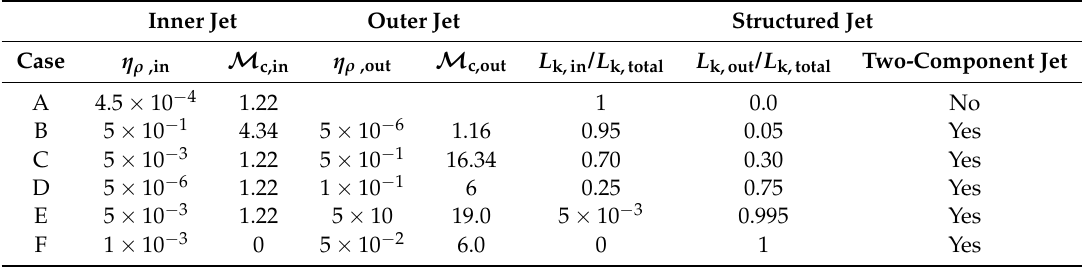
Table 1. Most relevant parameters for the two models investigated, the density ratio η ρ , the Mach number M c , the contribution of each jet components to the total kinetic energy flux of the jet L k,in / L k,total , L k,out / L k,total . In addition to these values, the external medium has a